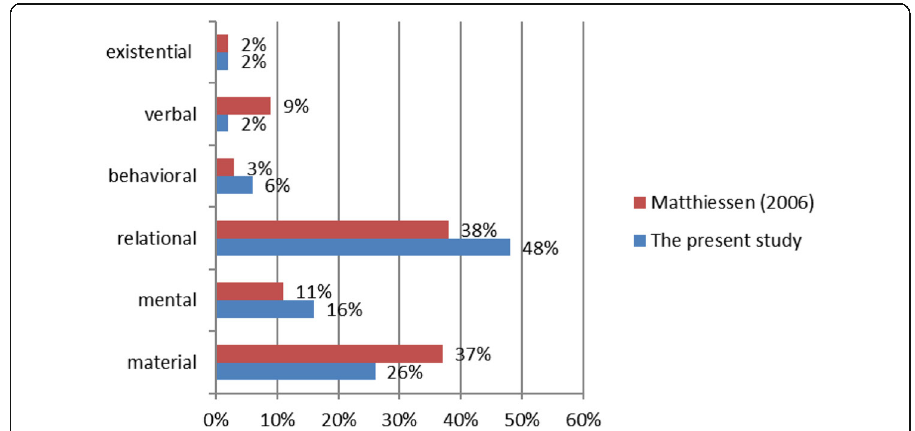
Fig. 3 The comparison of process types in two